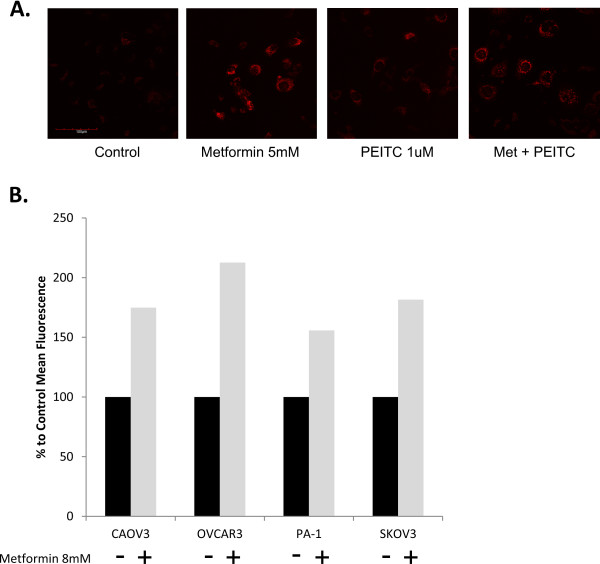
Mitochondrial reactive oxygen species (ROS) increased with metformin and PEITC treatment. A. Live cell confocal image of SKOV3 cells treated for 24 hours. MitoSOX, a mitochondrial specific superoxide detector, exhibits increased fluorescence in metformin and PEITC treated cells comparison to control treated cells. B. Mean fluorescence intensity from dihydroethidium (DHE) used to detect total cellular ROS. Cell lines were treated for 24 hours with or without metformin [8 mM] and DHE intensity was measured by flow cytometry.